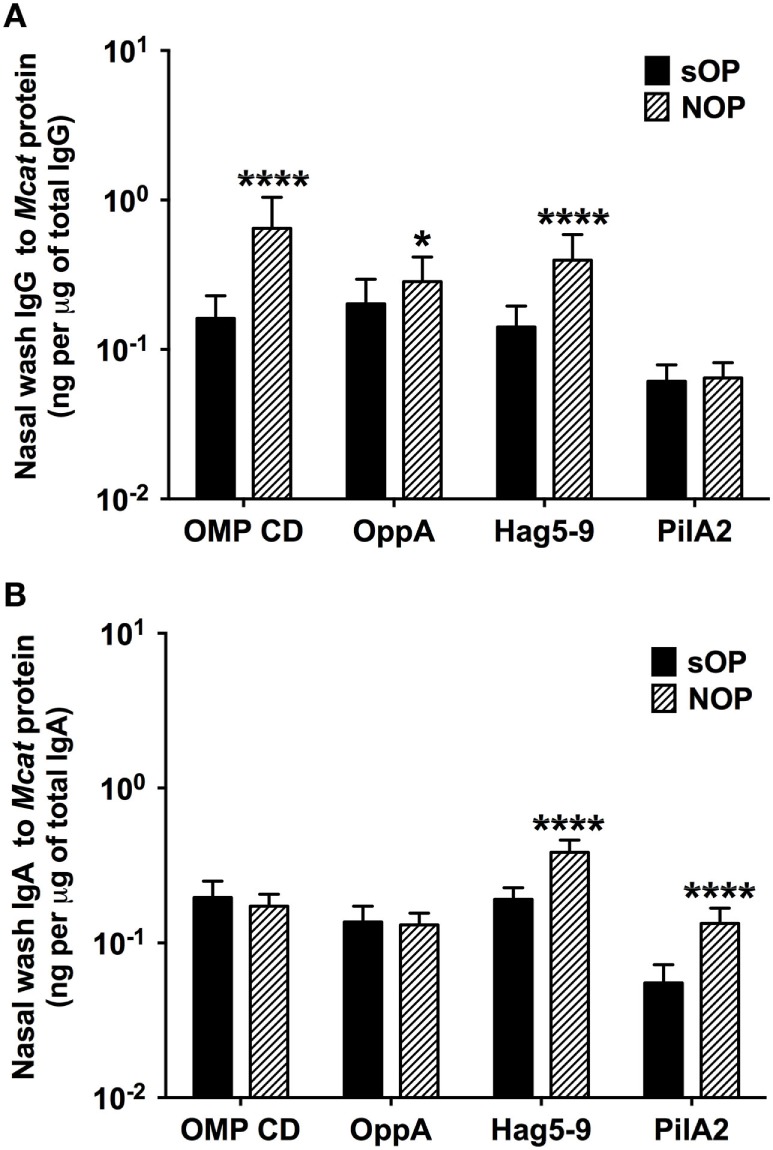
Mucosal antibody levels against Moraxella catarrhalis (Mcat) proteins in stringently defined otitis prone (sOP) and non-otitis prone (NOP) children. Nasal wash IgG and IgA against Mcat proteins outer membrane protein (OMP) CD, oligopeptide permease A (OppA), Hag5–9, and Pilin A clade 2 (PilA2) were detected by using enzyme-linked immunosorbent assay for children age 6–36 months old. Mcat protein-specific (A) IgG and (B) IgA in nasal wash were compared between 238 healthy visits of 59 sOP children and 270 healthy visits of 75 NOP children. IgG and IgA concentrations (ng/ml) were normalized with total IgG and IgA concentrations (μg/ml) in nasal wash, respectively, for comparison. Data are represented as geometric mean ± 95% confidence interval. Mann–Whitney test was used for comparisons. *P < 0.05 and ****P < 0.0001 comparing sOP vs. NOP children.